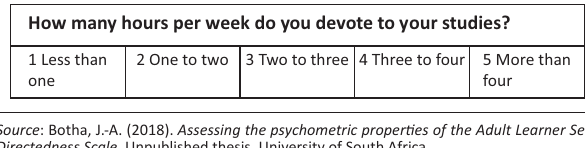
FIGURE 1: Adult Learner Self-Directedness Scale: Example of a scale item and response